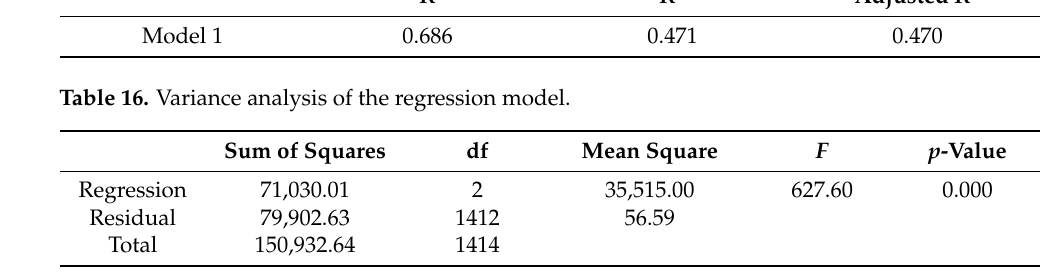
Table 15. Regression model summary.